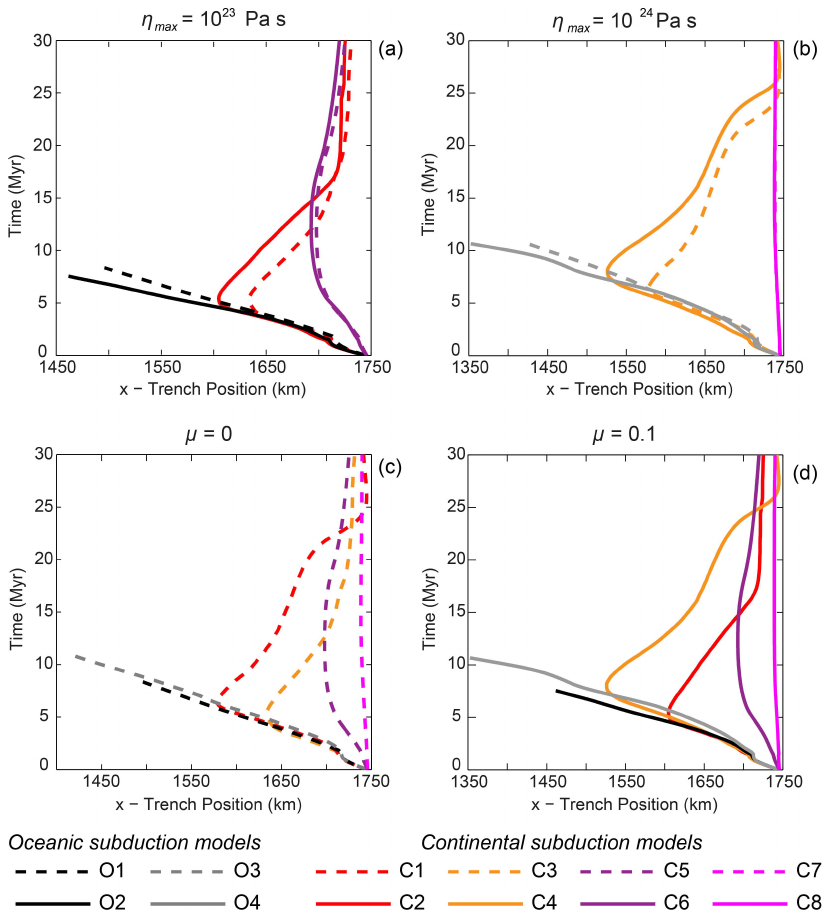
Fig. 5. Trench migration for all models of the parametric study with (a) maximum viscosity η max = 10 23 Pas, (b) η max = 10 24 Pas, (c) friction coefficient µ = 0 and (d) µ =0.1. Grey and black lines indicate the purely oceanic subduction, whereas the coloured lines are for continental models: red ( η max = 10 23 Pas) and orange ( η max = 10 24 Pas) are free overriding plate models; purple ( η max = 10 23 Pas) and magenta ( η max = 10 24 Pas) are models with a fixed overriding plate. Dashed lines show models with µ = 0, whereas solid lines are for models with µ =